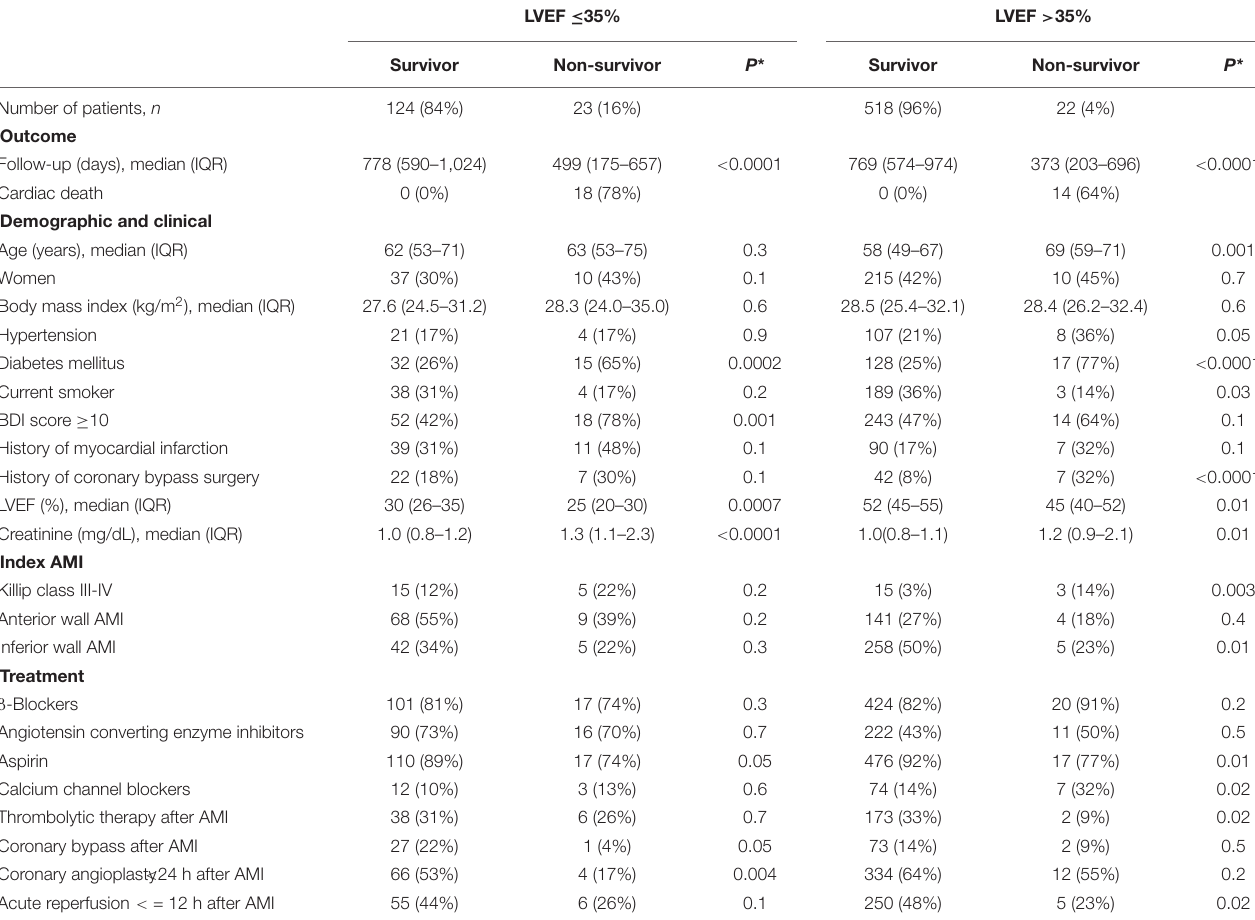
TABLE 1 | Patients’